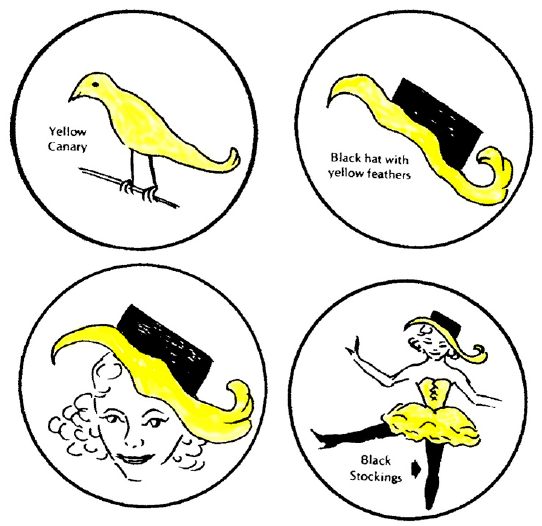
Figure 2. Sequence of projected visual images in response to the suggestion “yellow”.